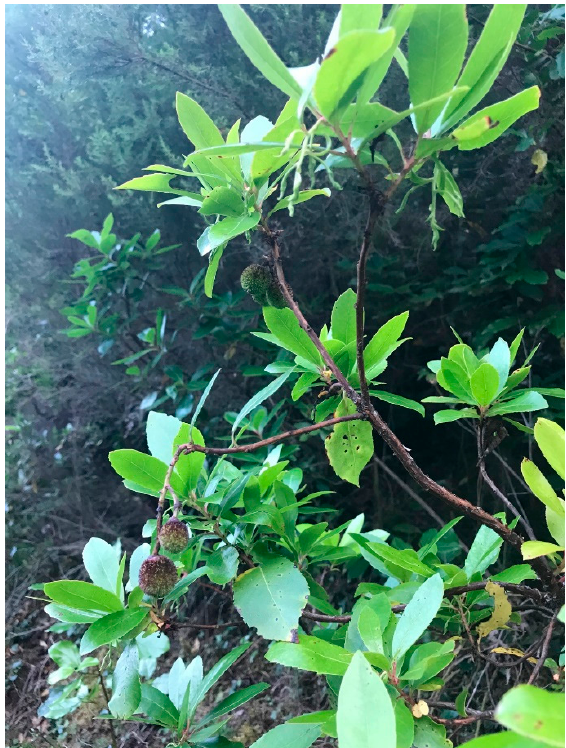
Figure 3. Arbutus unedo from Margaraça (Arganil, central Portugal).